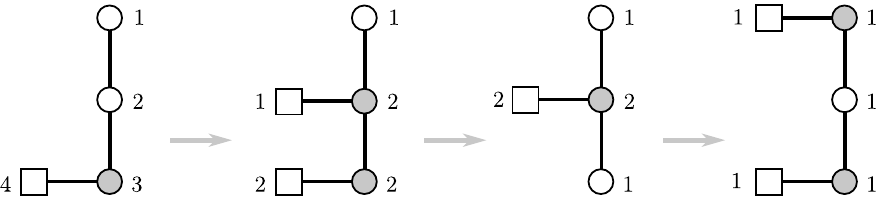
-type rational Q -system. All quivers corre- 3